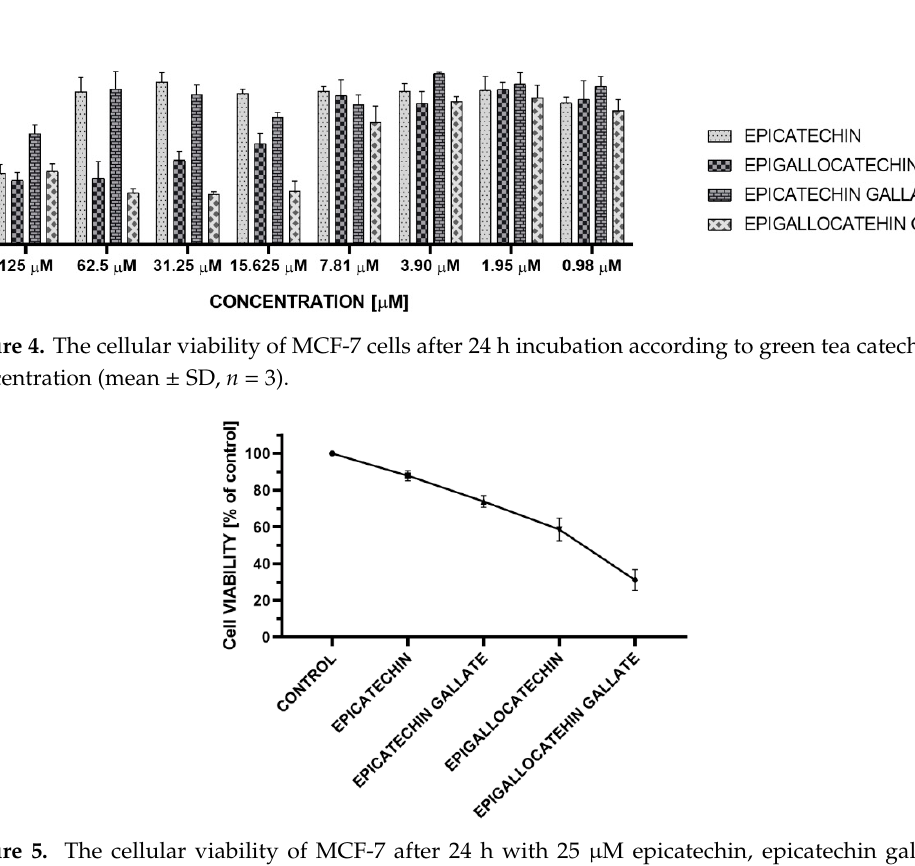
Figure 5. The cellular viability of MCF-7 after 24 h with 25 µ M epicatechin, epicatechin gallate, epigallocatechin, and epigallocatechin gallate. The cellular viability was measured by MTT assay (mean ± SD, n = 3). The results were presented as a percentage of control.